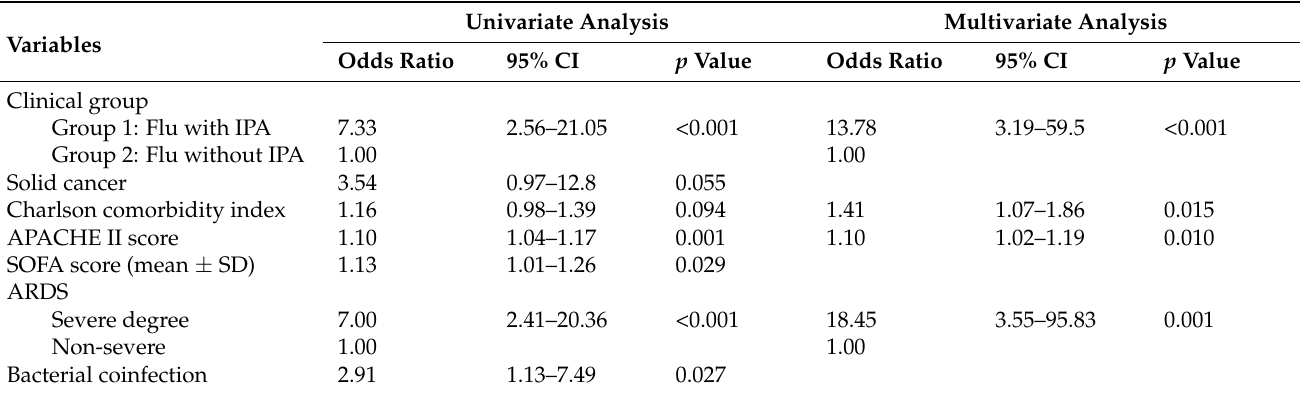
Table 5. Risk factors for in-hospital mortality ( n = 26) of severe influenza patients with and without aspergillosis (groups 1 and 2, n = 90) determined by using logistic regression